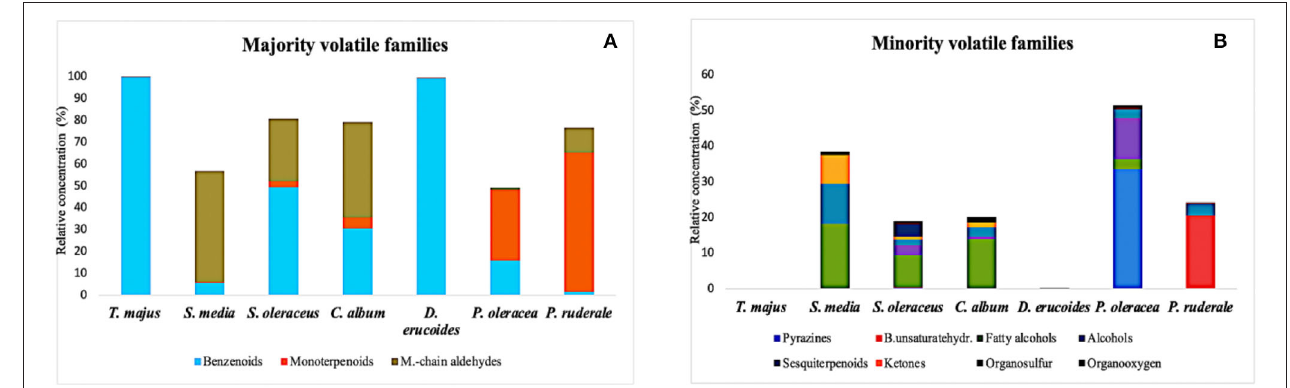
FIGURE 2 | Chemical families of volatiles and their relative content in the leaves of the seven undervalued species. (A) majority volatile families; (B) minority volatile families.